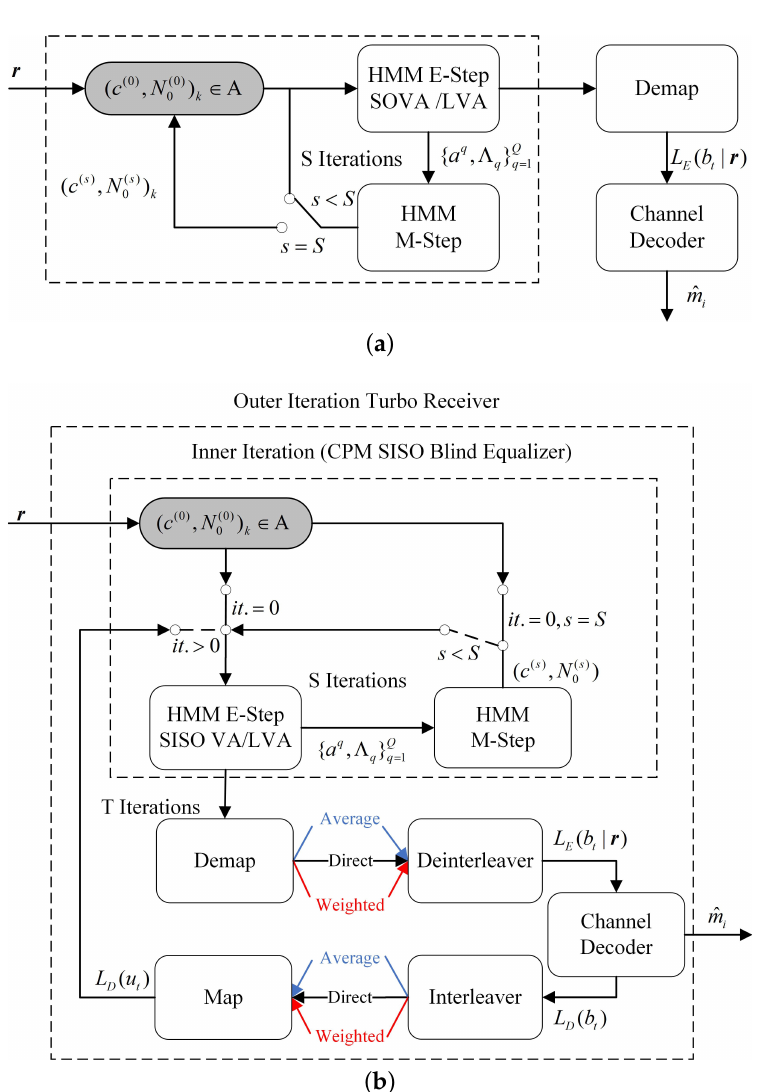
Figure 4. In ( a ), EMLVA blind equalizer block diagram. In ( b ), turbo EMLVA blind equalizer block